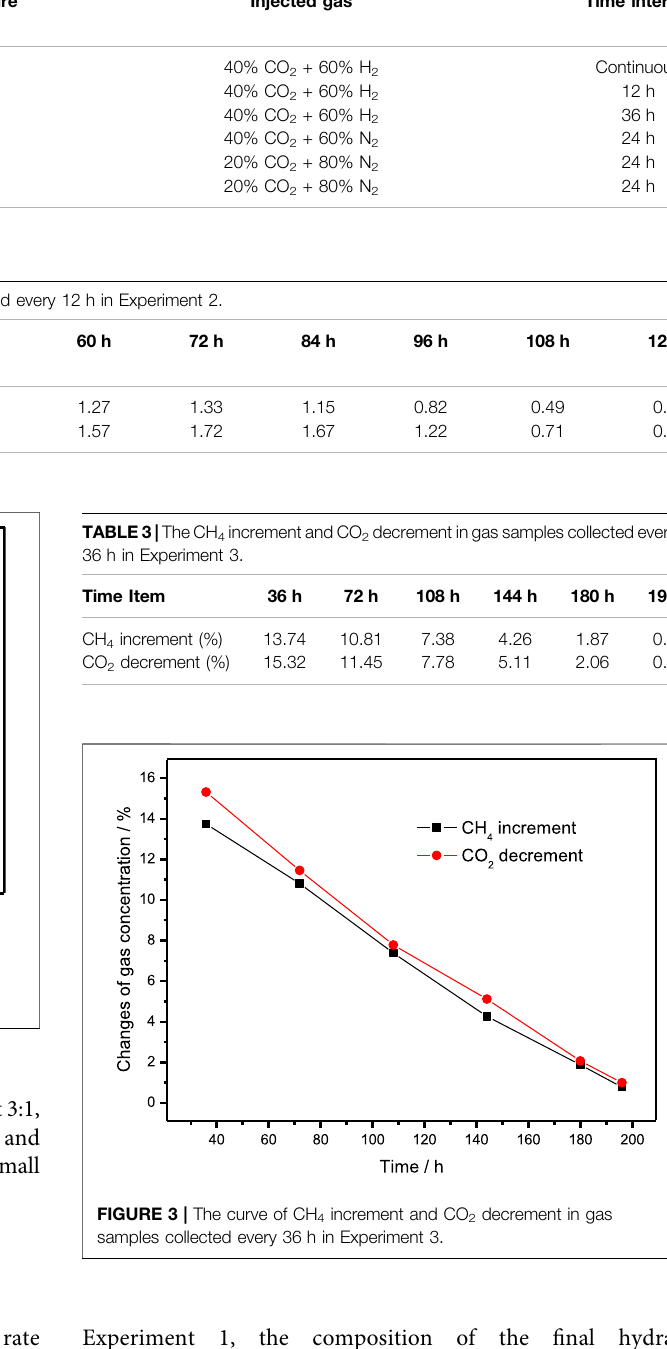
TABLE 1 | The conditions of three different gas exchange intervals in Experiment 1, 2, 3, 4, 5 and 6. Experiment number